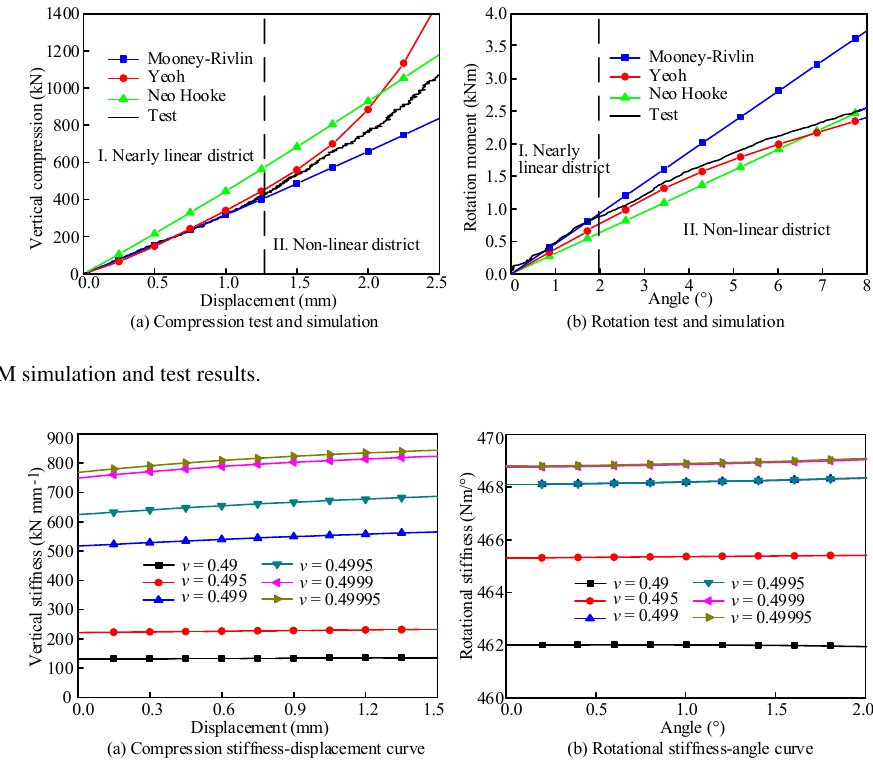
Figure 12. Vertical/rotational stiffness variation along with vertical